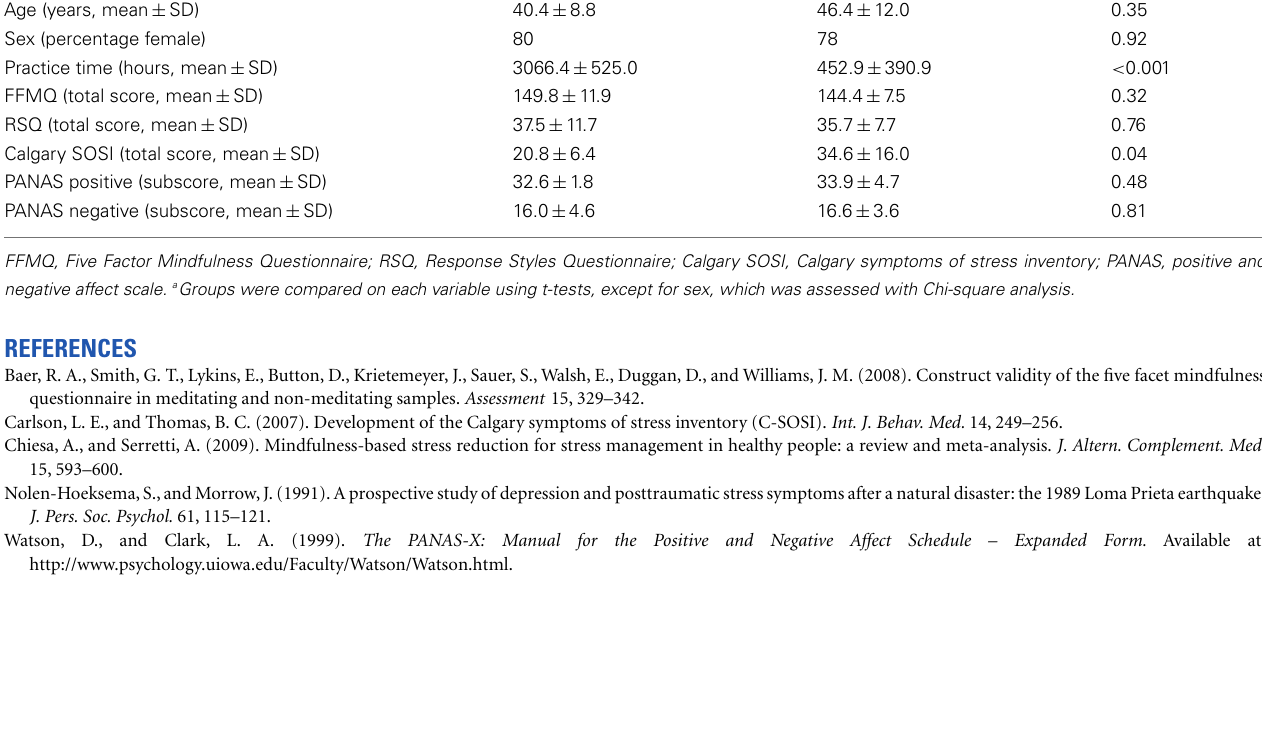
High practice Low